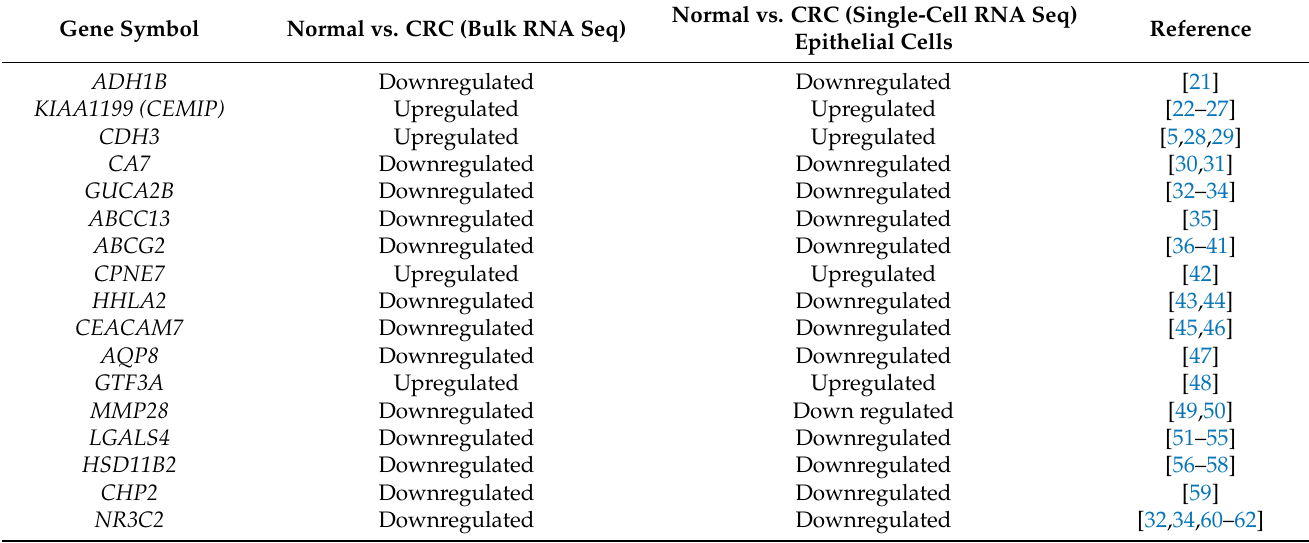
Table 1. List of the 17 genes and evidence of their involvement in regulation across normal and CRC patients. Gene Symbol Normal vs. CRC (Bulk RNA Seq)